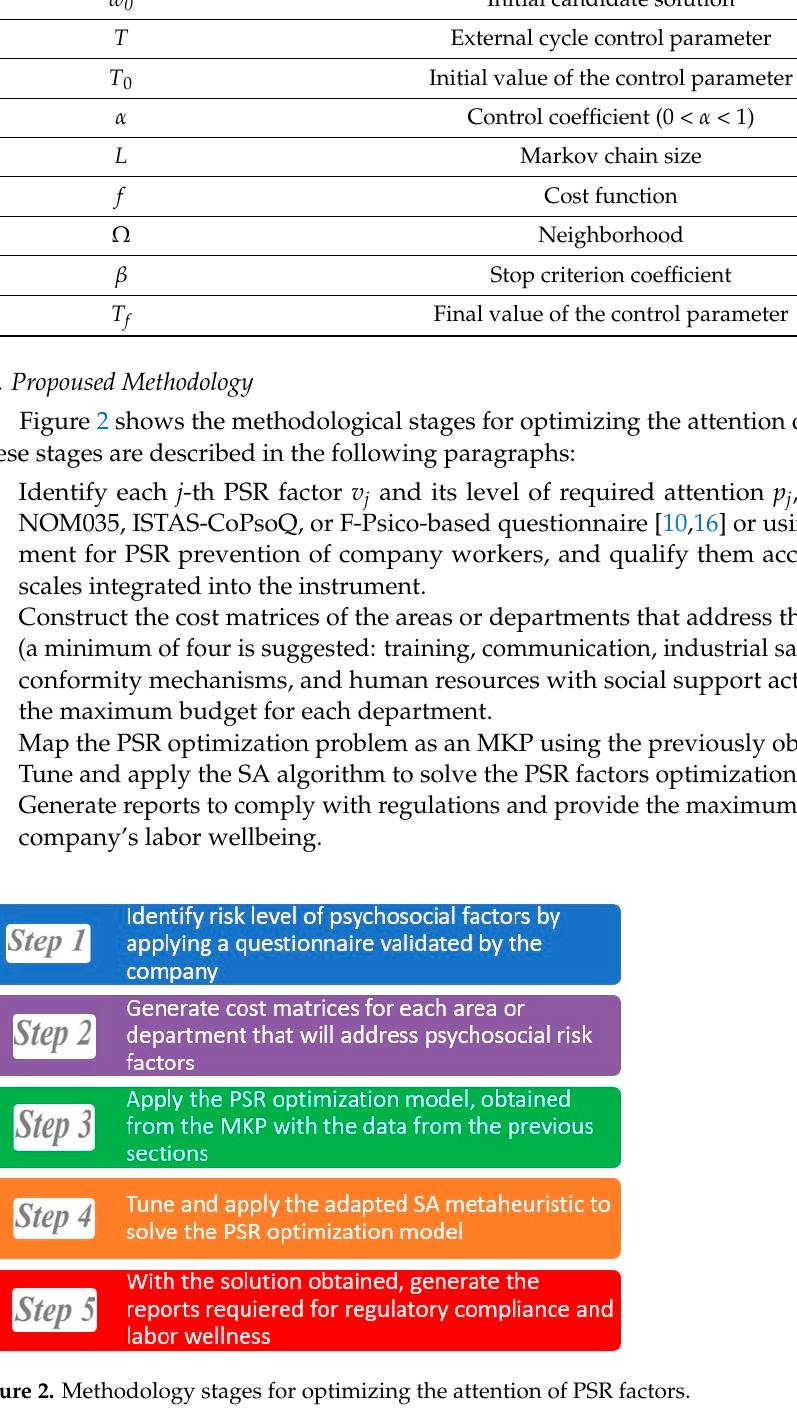
Table 1. SA parameters.